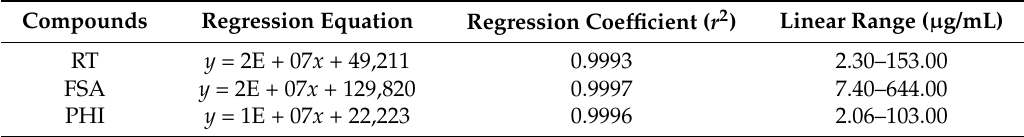
Figure 11. The HPLC chromatograms of the standards and sample (278 nm) obtained by UAE (1. rutin, 2. forsythiaside A, 3. phillyrin). Table 4. Regression parameters of HPLC-DAD analysis for the three compounds.